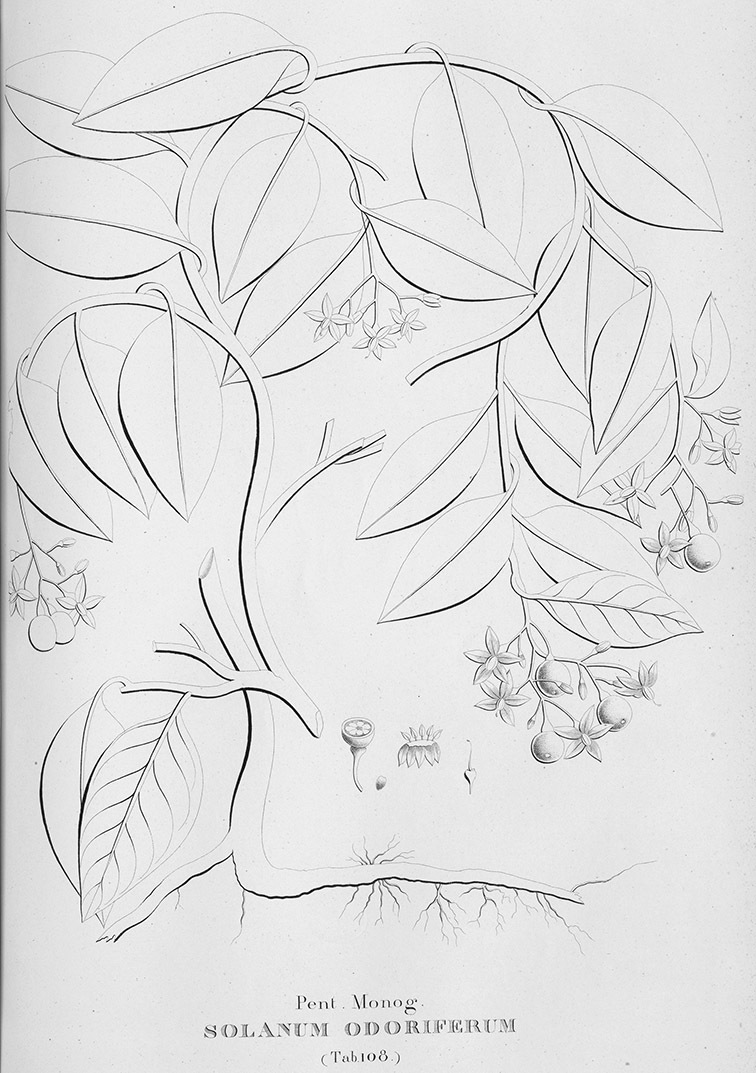
Lectotype of Solanum odoriferum Vell. (Vellozo 1831: tab. 108) Reproduced with permission of the Natural History Museum Botany Library.